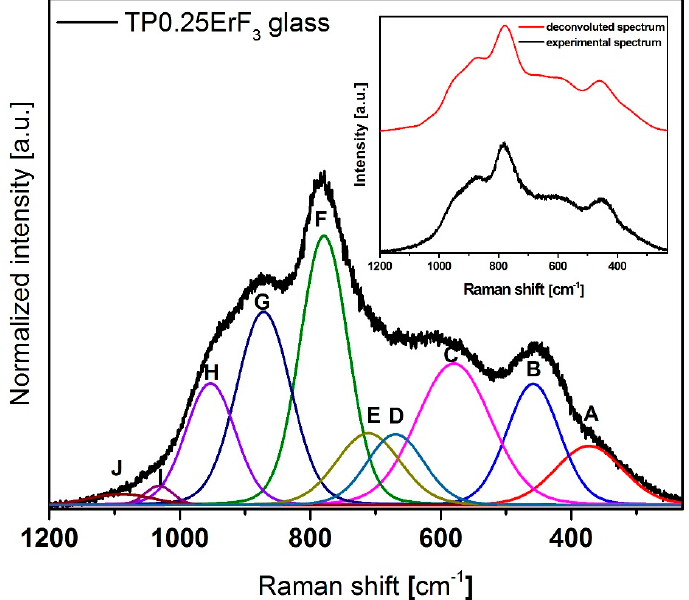
Figure 9. Deconvoluted Raman spectra of TP0.25ErF 3 glass. (inset) Deconvoluted and experimental spectra.